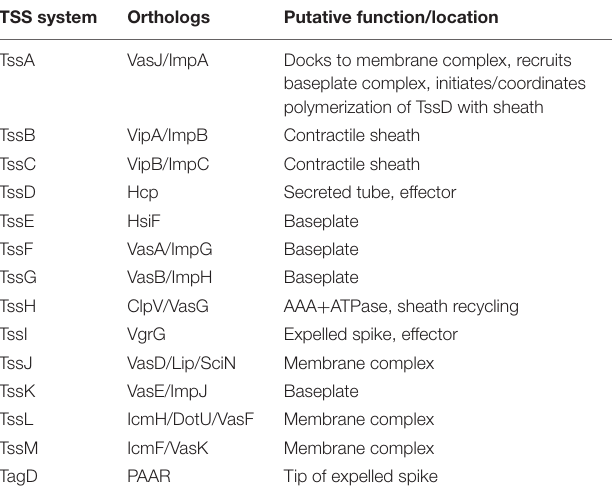
TABLE 1 | Components of the bacterial Type VI Secretion